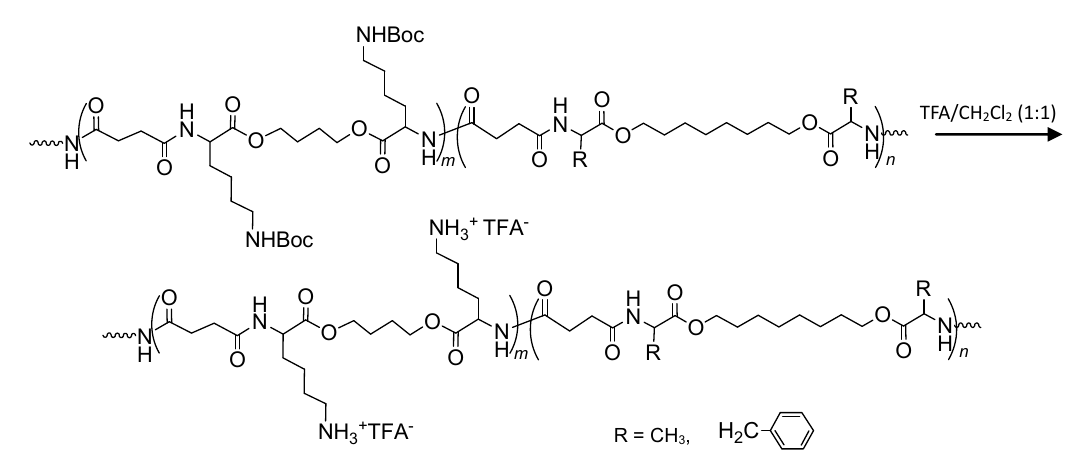
Figure 30. Cationic AABBP composed of bis-( L -lysine)-1,4-butylene diester.